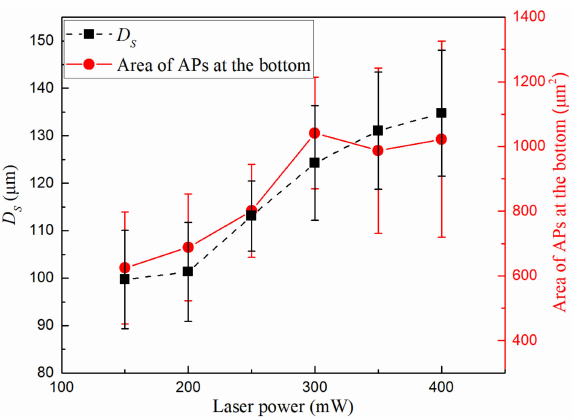
Figure 3. D S at different laser power. The area of the APs at the microbubble bottom was drawn with a red solid line. Left vertical coordinate is D S and right vertical coordinate is the area of the APs. c = 3.0 × 10 6 cm − 3